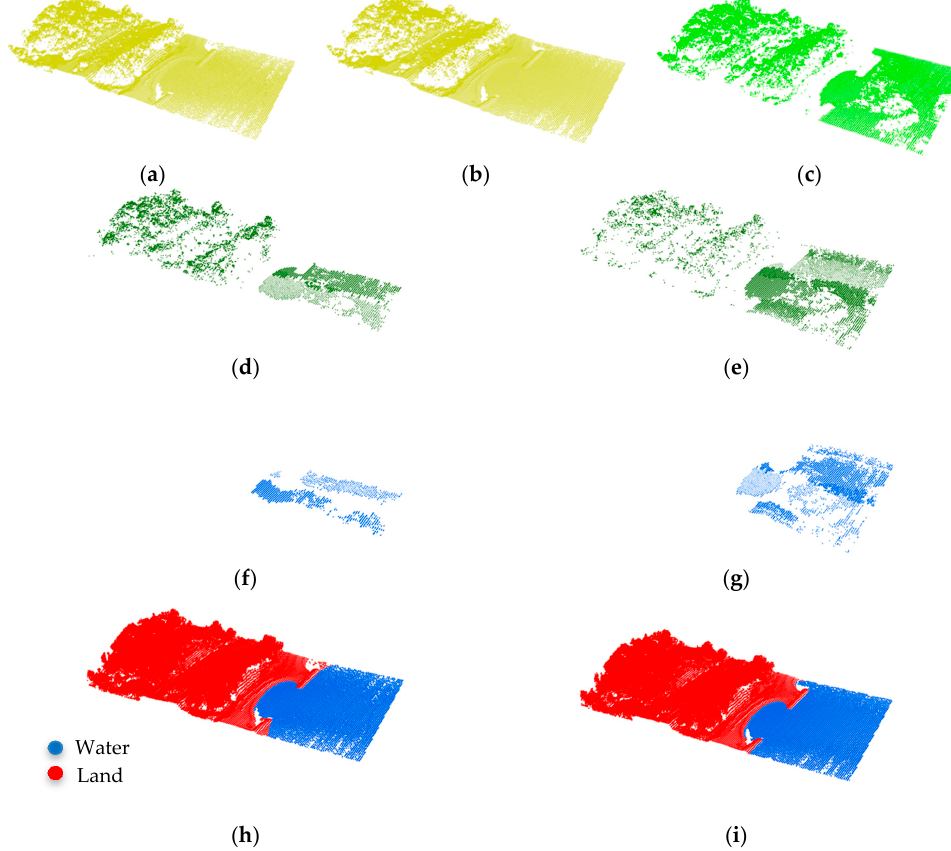
Figure 8. LiDAR points based on seeded region growing algorithm. ( a – c ) Single Returns of C1, C2 and C3; ( d – e ) Possible Seed Points using C1 with C3 and C2 with C3; ( f – g ) Water Seed Points using C1 with C3 and C2 with C3; ( h – i ) Seeded Region Growing using C1 with C3 and C2 with C3. Table 8. Accuracy measures of labeled points based on seeded region growing. The best results are highlighted in bold.